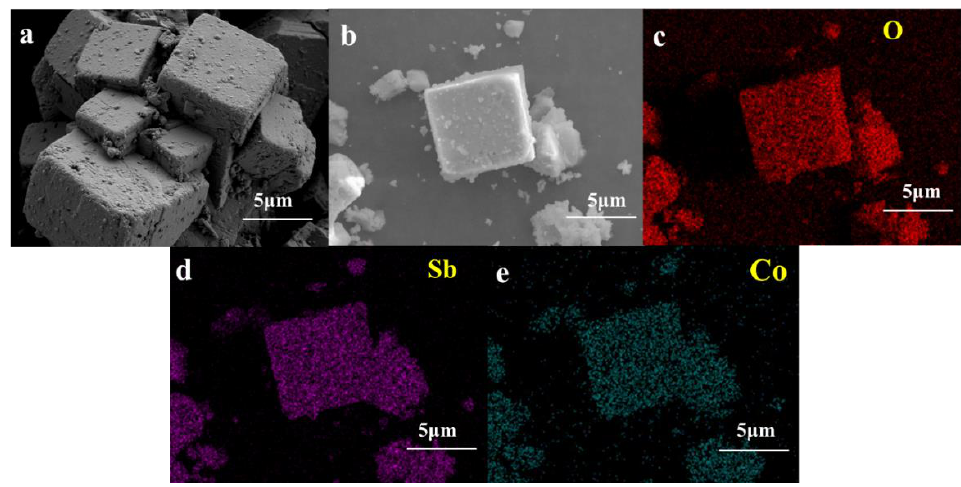
Figure 3. The SEM analysis results of CSO ( a , b ) and EDS mapping results of O ( c ), Sb ( d ), and Co ( e ).